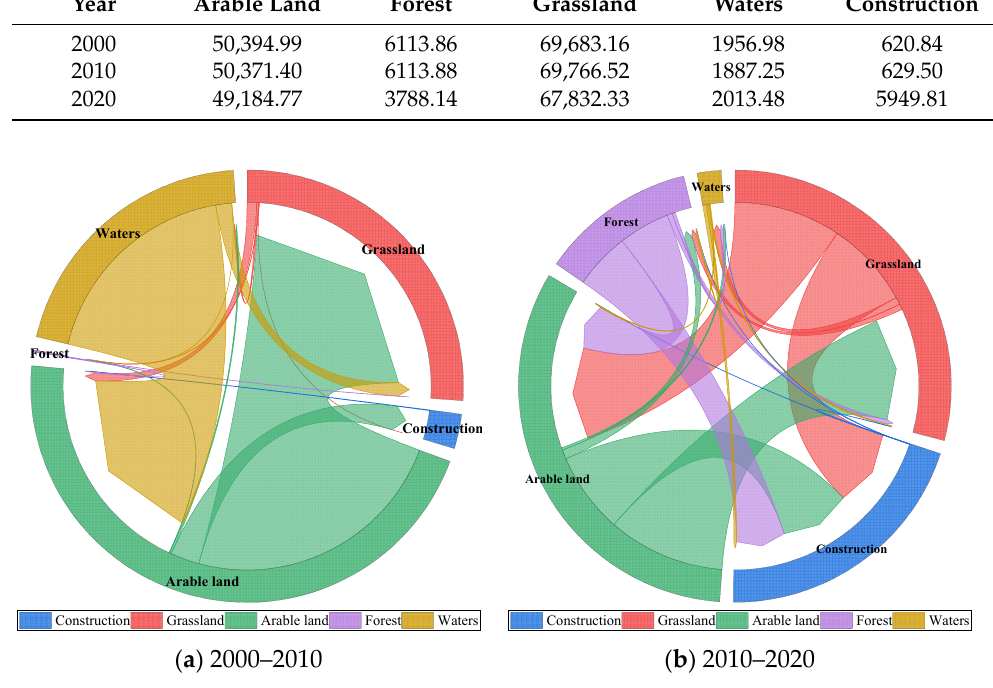
Figure 2. Land use transfer matrix (unit: hm 2 ). The arrow in the figure indicates the direction of land type converted, and the thickness of the arrow represents the size of the converted area.